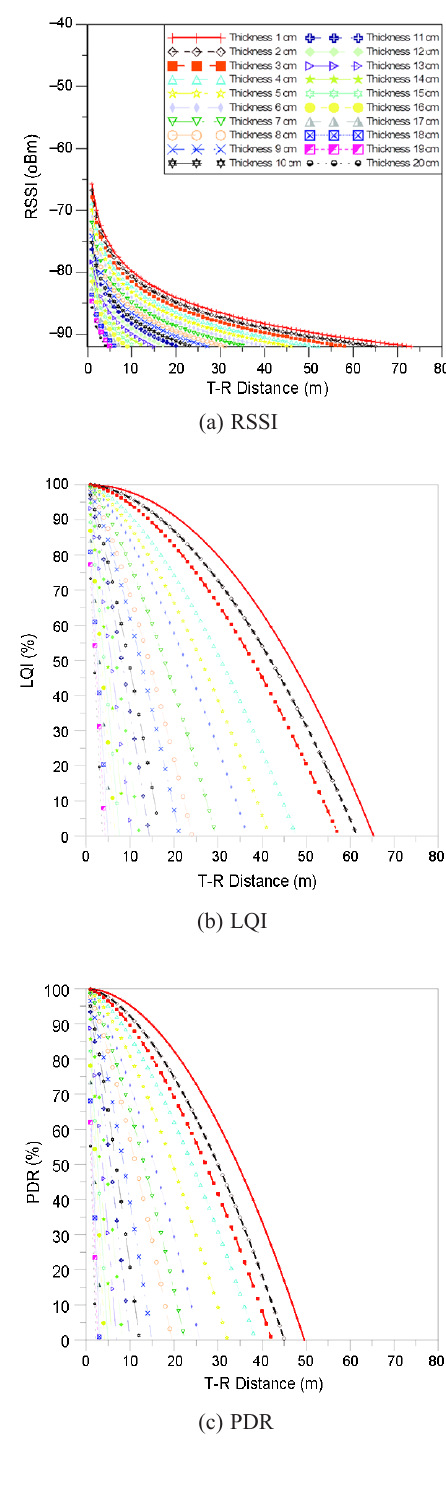
Fig. 2. Extended regression function (ERF) for concrete block Fig. 3. Extended regression function (ERF) for steel